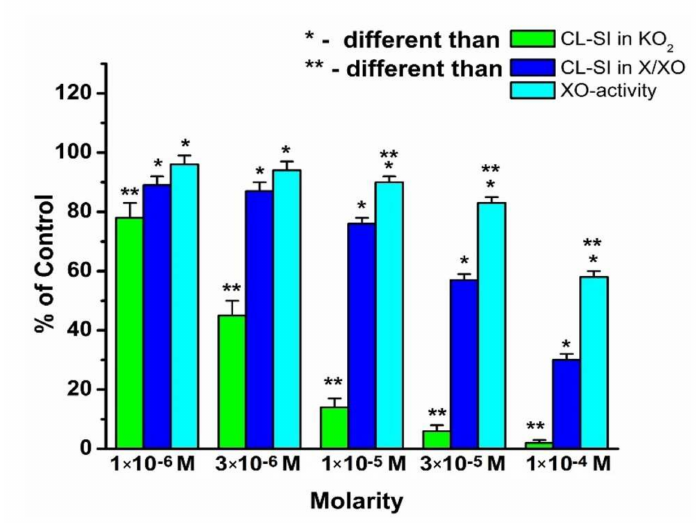
Figure 3. Radical-scavenging activity of GaAOA toward superoxide radicals formed in KO 2 and X/XO model systems, and activity of XO in the formation of uric acid (UA) in the X/XO model system. Data = mean ± StDev, p < 0.05.